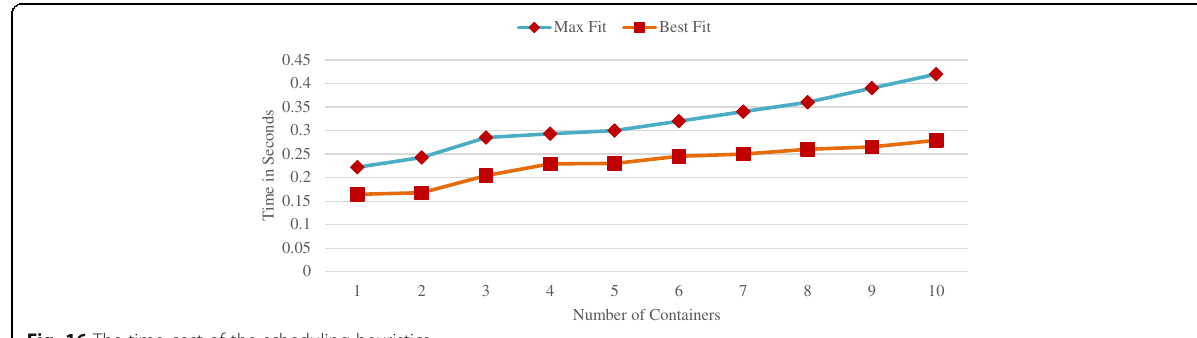
Fig. 16 The time cost of the scheduling